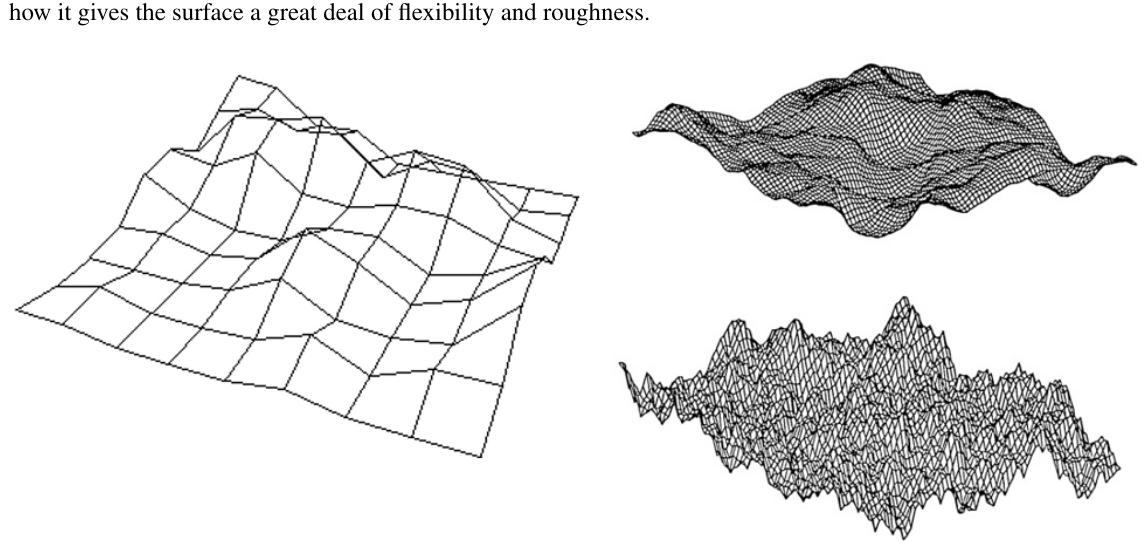
Figure 7. Three levels of deforming a self-affine fractal